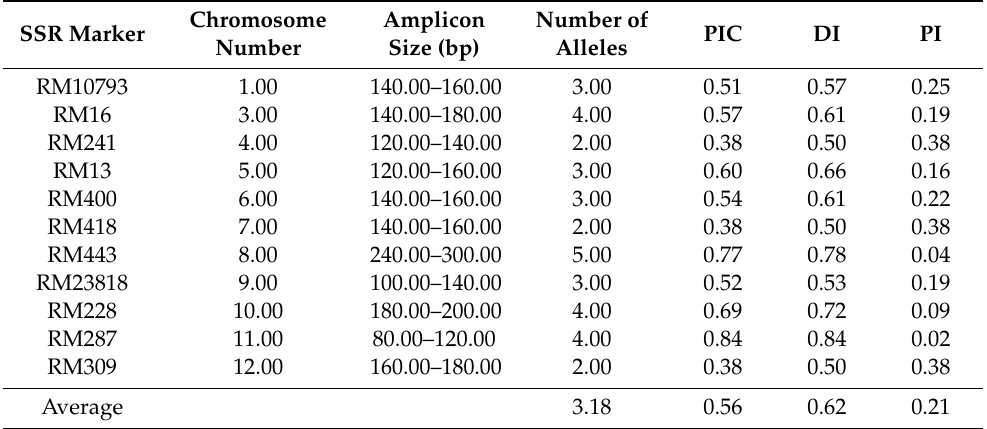
Table 2. Primer information and diversity parameters of 11 simple sequence repeats (SSRs) markers applied in this study. bp: Base Pair, PIC: Polymorphic Information Content, DI: Diversity Index, and PI: Probabilities of Identity.